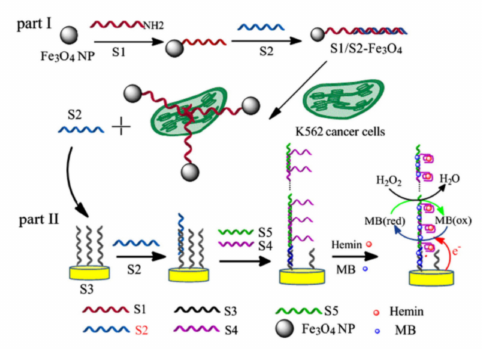
Figure 13. Schematic representation of the signal-amplified electrochemical aptasensor based on supersandwich G-quadruplex DNAzyme [220]. Copyright 2015 Elsevier